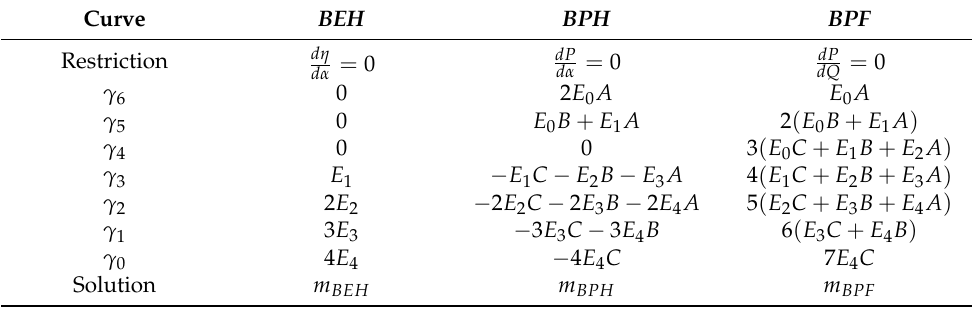
Table 2. Coefficients for the knowledge of the m parameters.